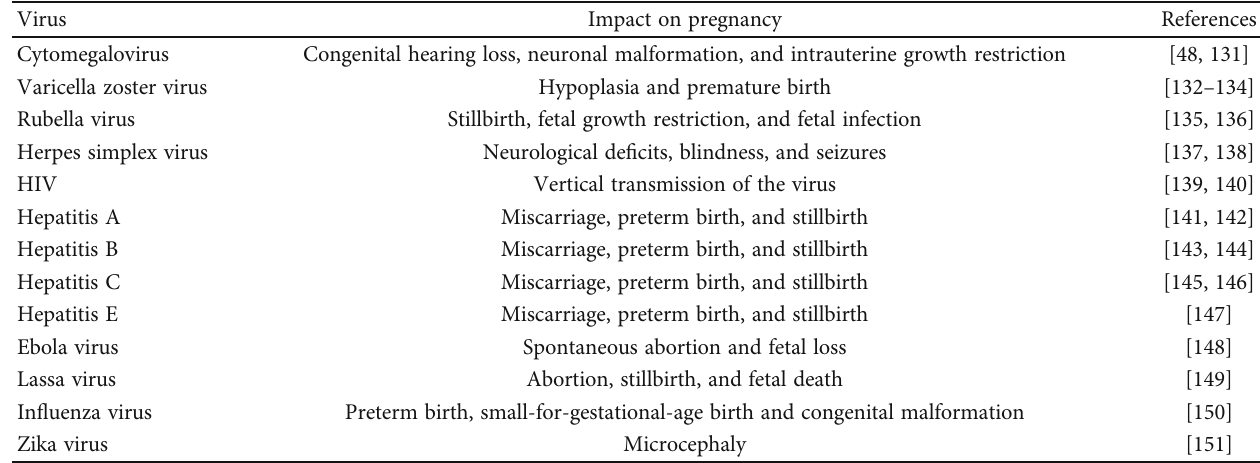
Table courtesy Gil Mor et al.